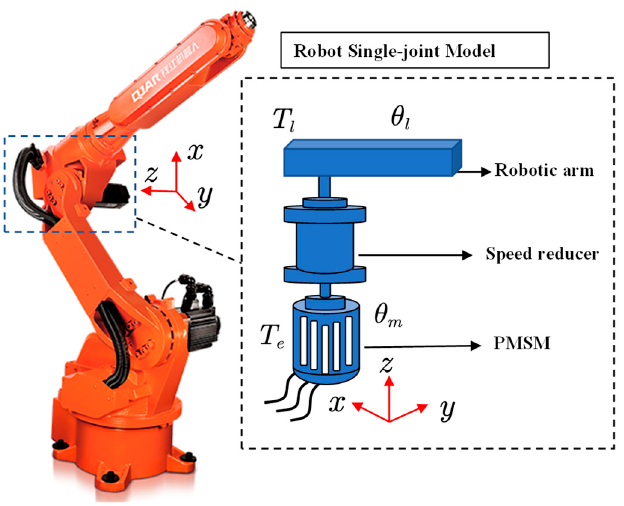
Figure 1. The schematic diagram of a single joint of an industrial robot.